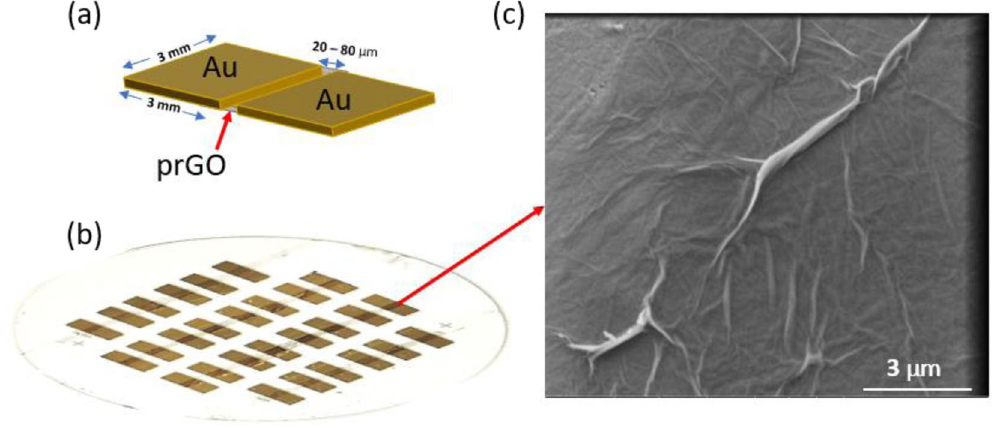
Figure 1. NeuroMem structure: ( a ) Device schematic to show the planar Au/prGO/Au structure (Drawing Software: Microsoft Powerpoint 2016). ( b ) A macrograph of the fabricated NeuroMem devices on COC substrate. ( c ) Scanning electron microphotograph of the deposited prGO layer, top view, under secondary electron mode (accelerating voltage, 5 kV; magnification, 24 000 × ; working distance, 10